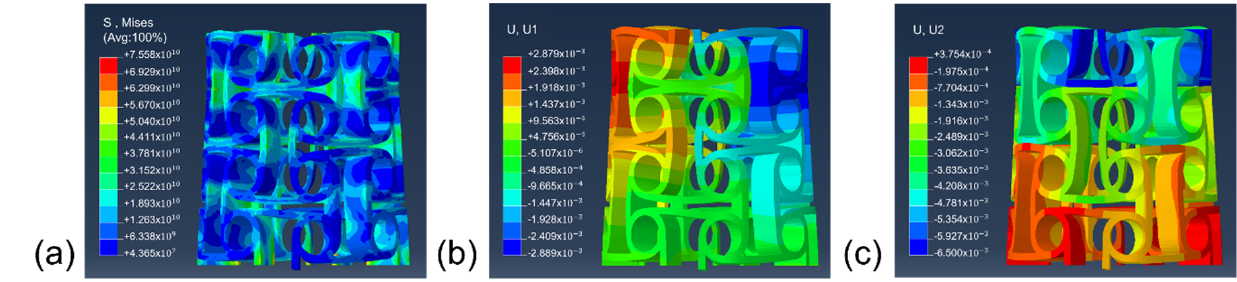
Figure 5. Poisson’s ratio for the four models without rings.